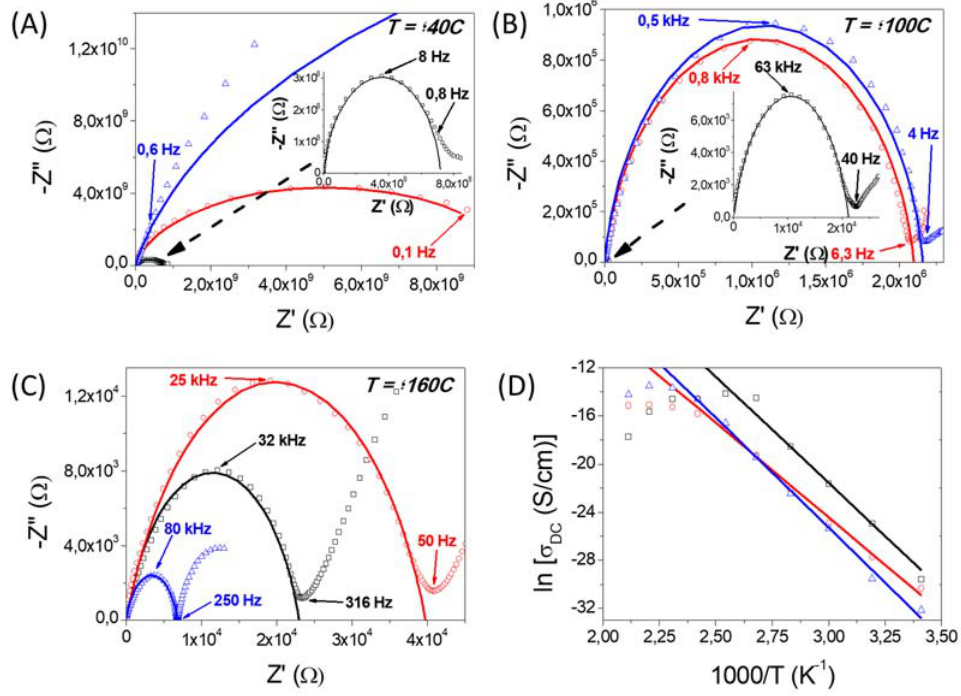
Figure 7. ( A–C ) Cole ‐ Cole plots of the complex impedance measured in dry conditions at different membrane temperatures for the samples: ( ) PBI@SiNF, ( ) PBI@SiNF–NH 2 and ( ) PBI@SiNF–SO 3 H. ( D ) The solid line represents the fitting to the equivalent circuit models shown in Figure 6A. The inset in plots at 40 and 100 C corresponds to the small arc indicated by the arrow and observed for the composite membrane PBI@SiNF.